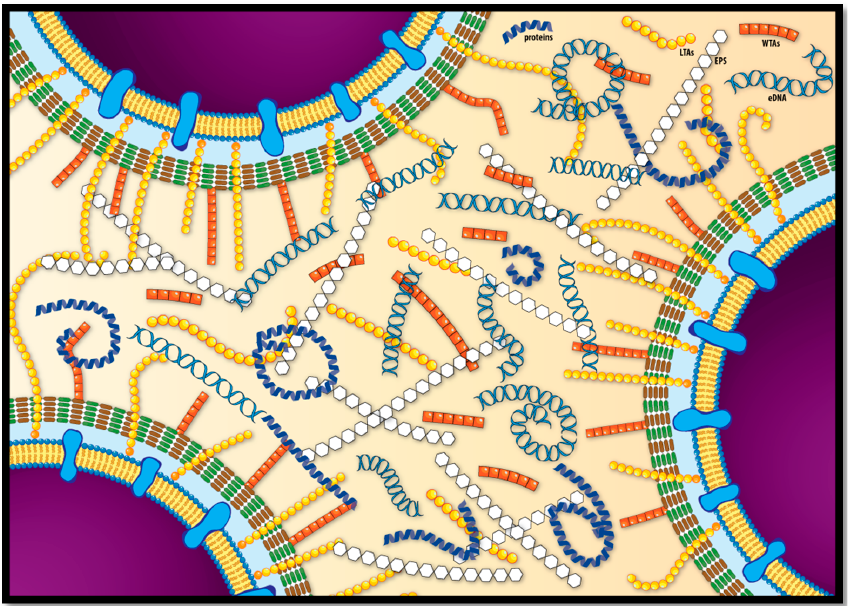
Figure 2. Schematic representation of listerial extracellular biofilm matrix. The major components (EPS’s, WTAs, LTAs, proteins, and eDNA) are distributed heterogeneously within the matrix. Acknowledgments: The following authors (Pierluigi Di Ciccio and Adriana Ianieri) are members of the EU COST Action FA1202 (CGA-FA1202): A European Network for Mitigating Bacterial Colonisation and Persistence on Foods and Food Processing Environments and acknowledge this action for facilitating collaborative networking that assisted with this